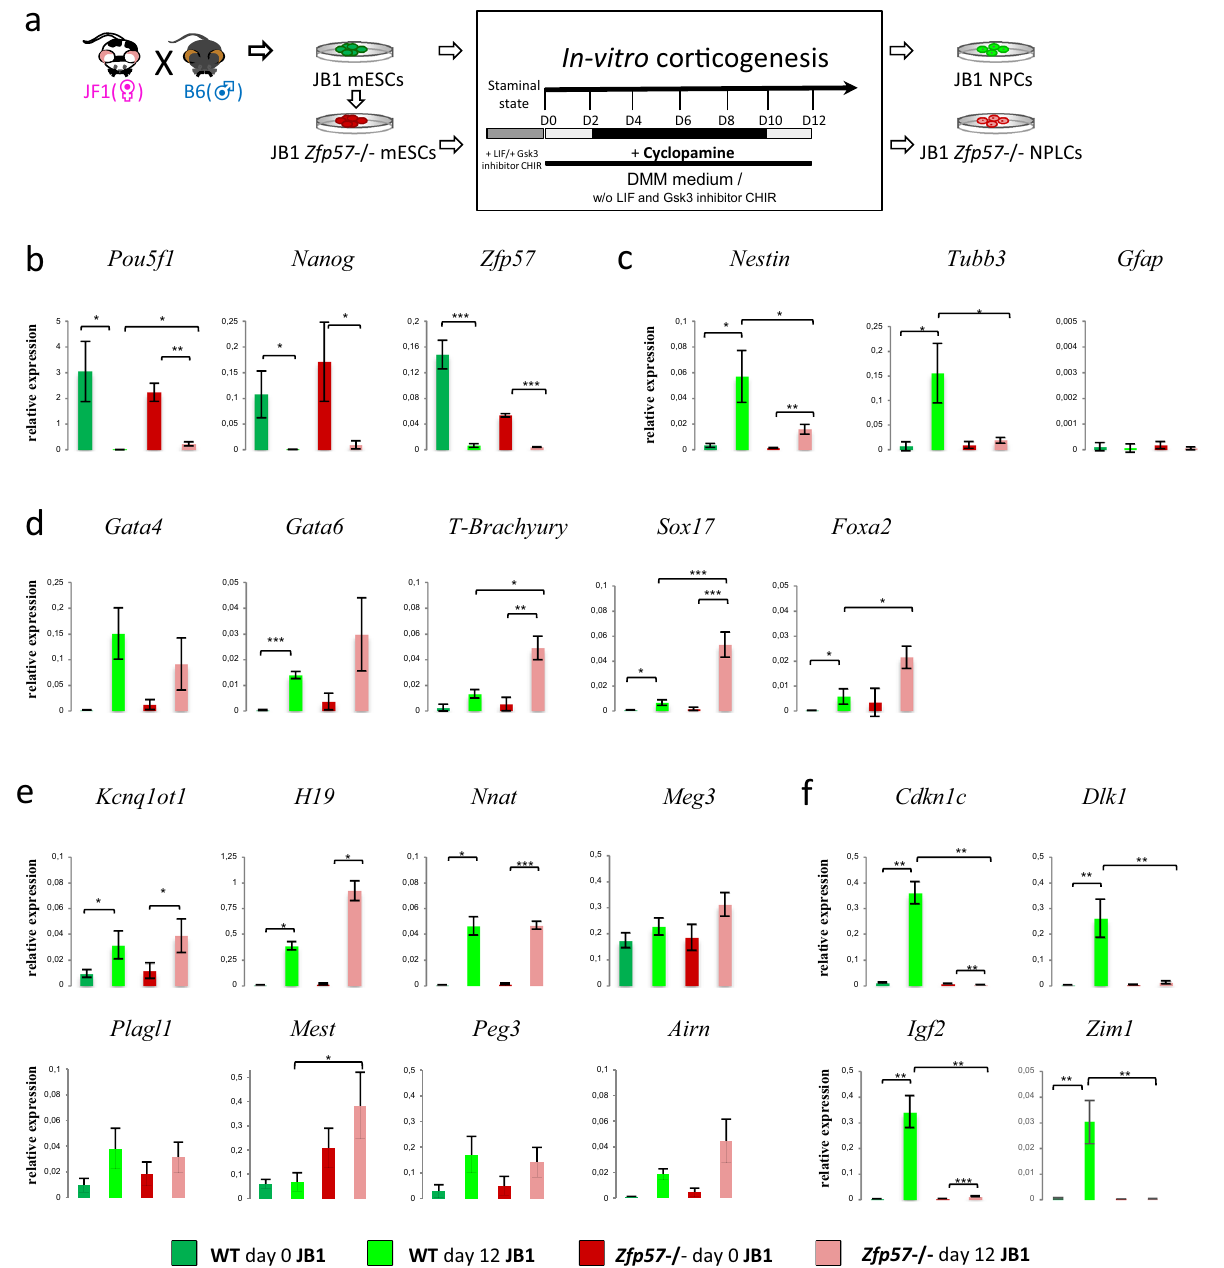
Figure 1. Differentiation protocol and marker expression analysis of wild-type and Zfp57 -/- hybrid cells. ( a ) Schematic of neural differentiation. Wild-type and Zfp57 -/- JB1 ESCs were cultured in DDM medium for 12 days and 1 μM cyclopamine was added from day 2 to day 10 to induce dorsalization of progenitor cells. At day 12 neural progenitor cells were harvested. ( b–d ) Expression analysis of pluripotency (b) , neural (c) and endoderm- mesoderm (c) differentiation markers and imprinted genes (e,f) in wild-type and Zfp57 -/- JB1 ESCs (day 0) and NPCs (day 12) assayed by quantitative RT-qPCR. The histograms show the average gene expression levels of three independent experiments, after normalization against the level of β-actin . Error bars represent the SD. Note that Zfp57 expression was detected with the use of primers external to the deletion introduced during the gene